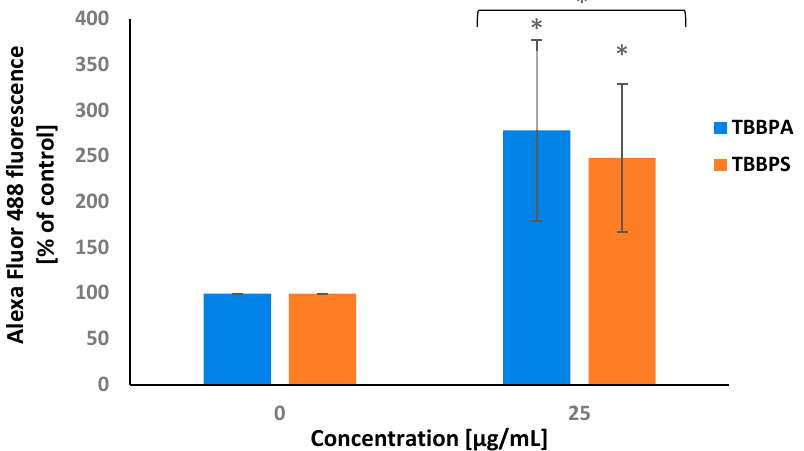
Figure 6. Alterations in DNA fragmentation in PBMCs incubated with TBBPA and TBBPS at 25 µg/mL (n = 3) for 24 h. Statistically different from negative control at * p < 0.05. Statistical analysis was conducted using Welch’s test.